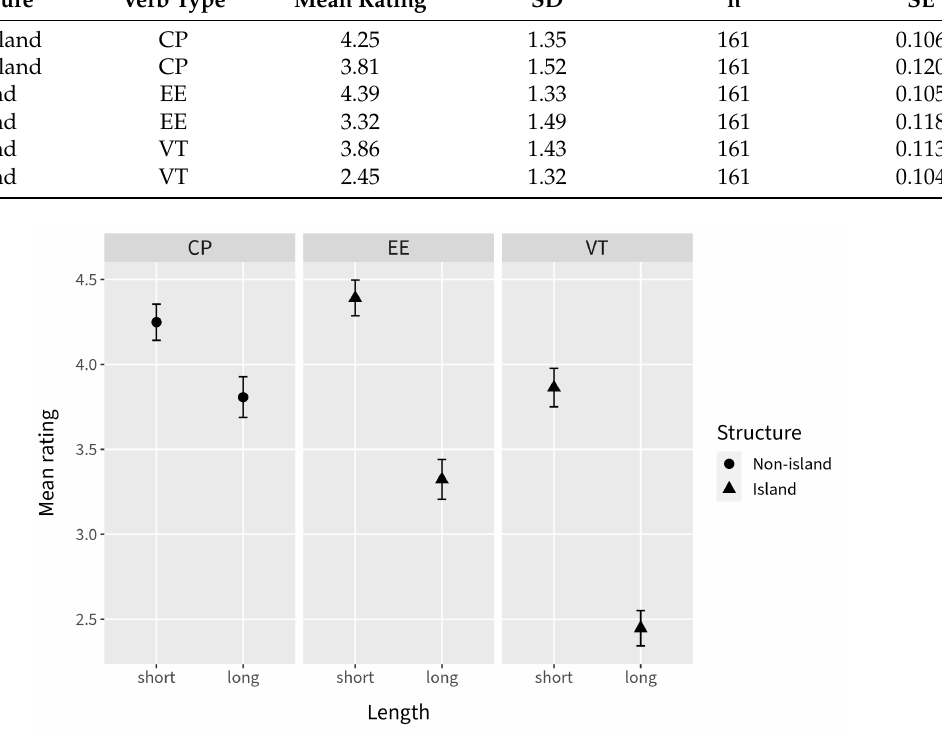
Figure 6. Mean ratings for Experiment 2. Error bars represent the standard error. Mean is calculated on raw (non-z-scored)